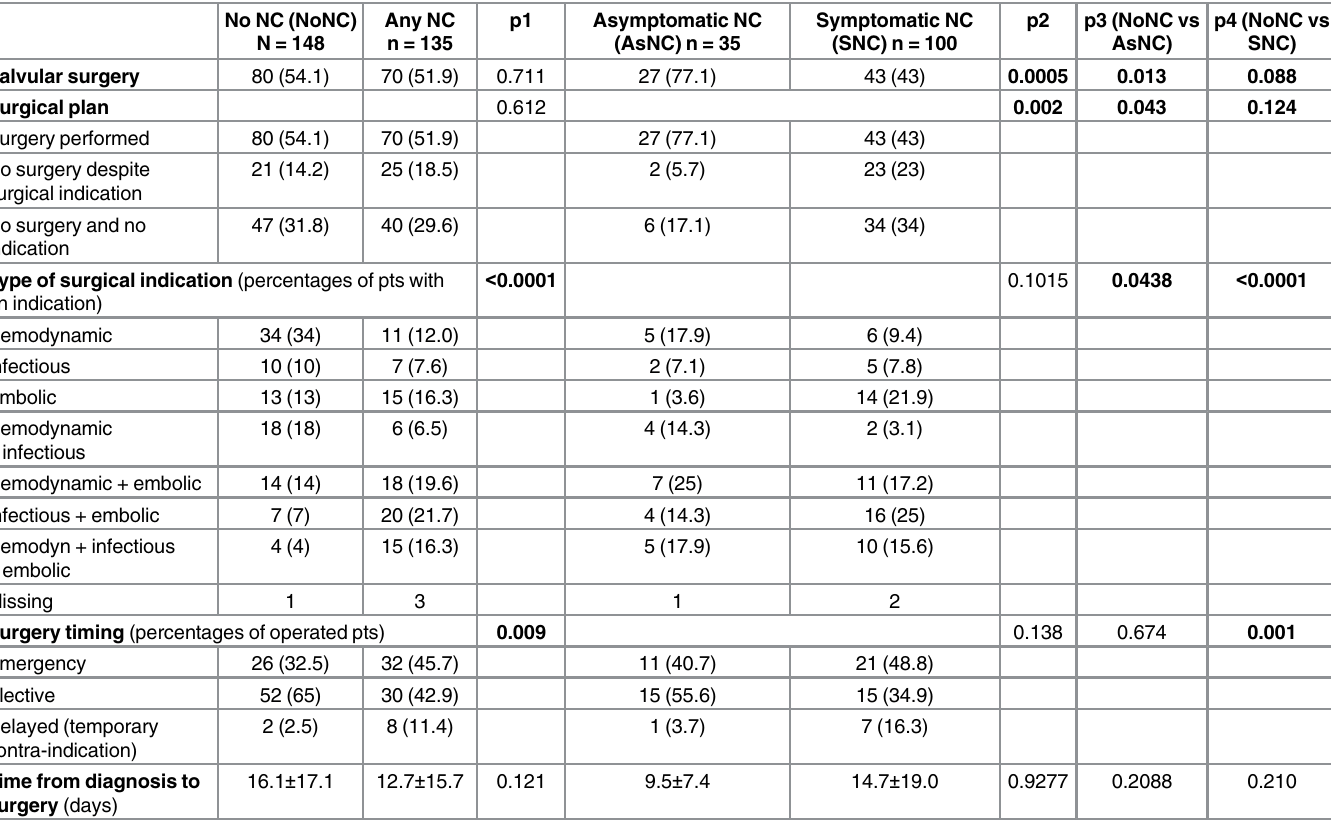
Table 3. Comparison of surgical therapy among patients according to the absence or the presence of neurological complications (NC) either asymptomatic or